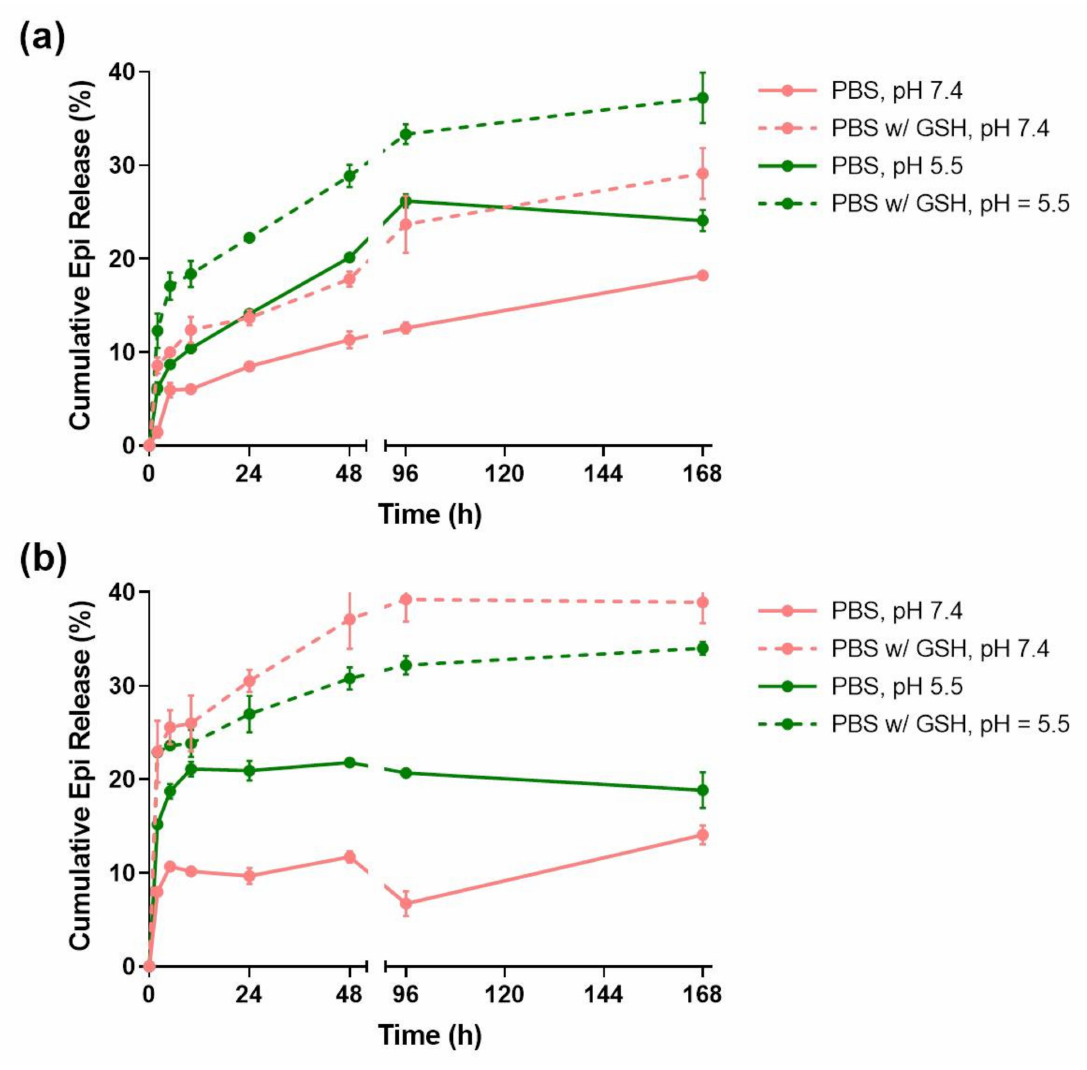
Figure 3. Epirubicin release profiles of TMSN ( a ) and TMSN-NH 2 ( b ) under relevant biological conditions. Data are expressed as percentage of cumulative epirubicin released and showed as mean ± standard deviation obtained from